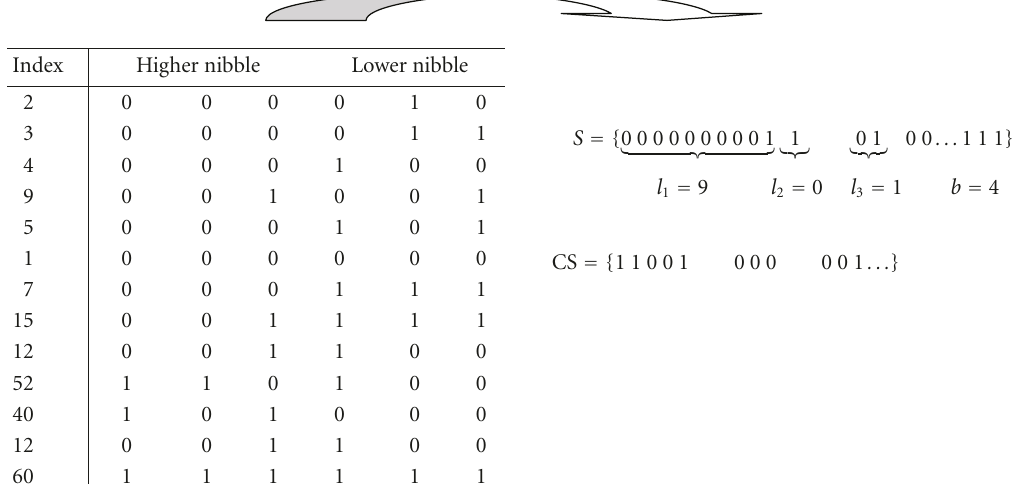
Figure 6: Index sequence compression (multistage = 1).